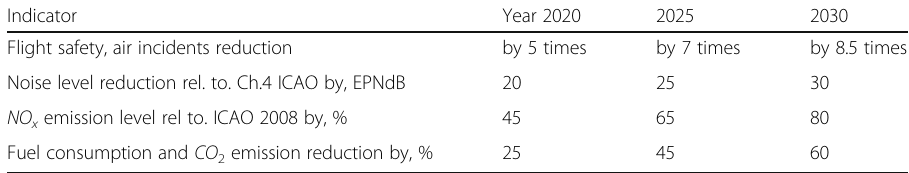
Table 1 Prognosis on changes in main aircraft aimed perfection indicators